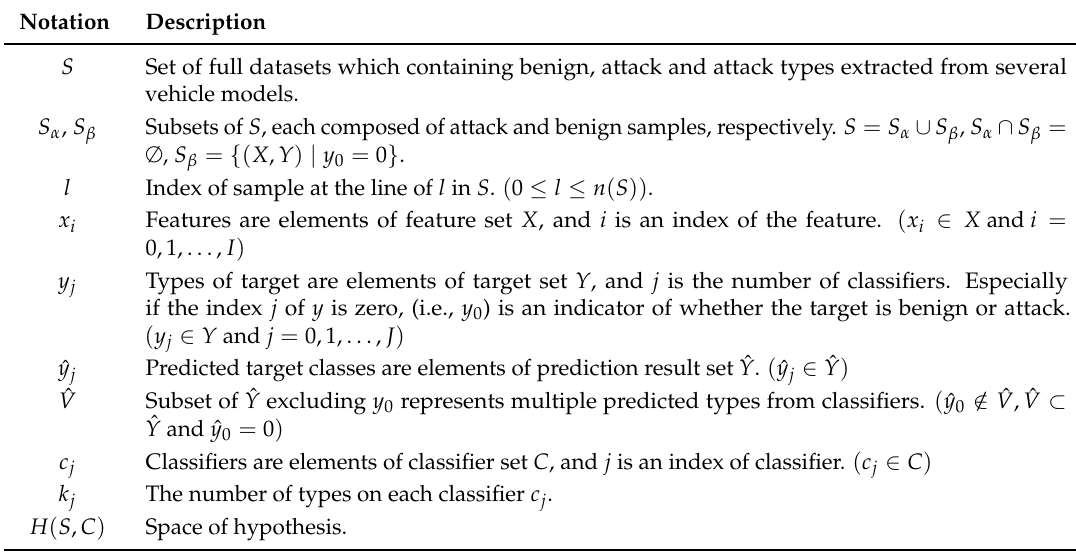
Table 5. Summary of